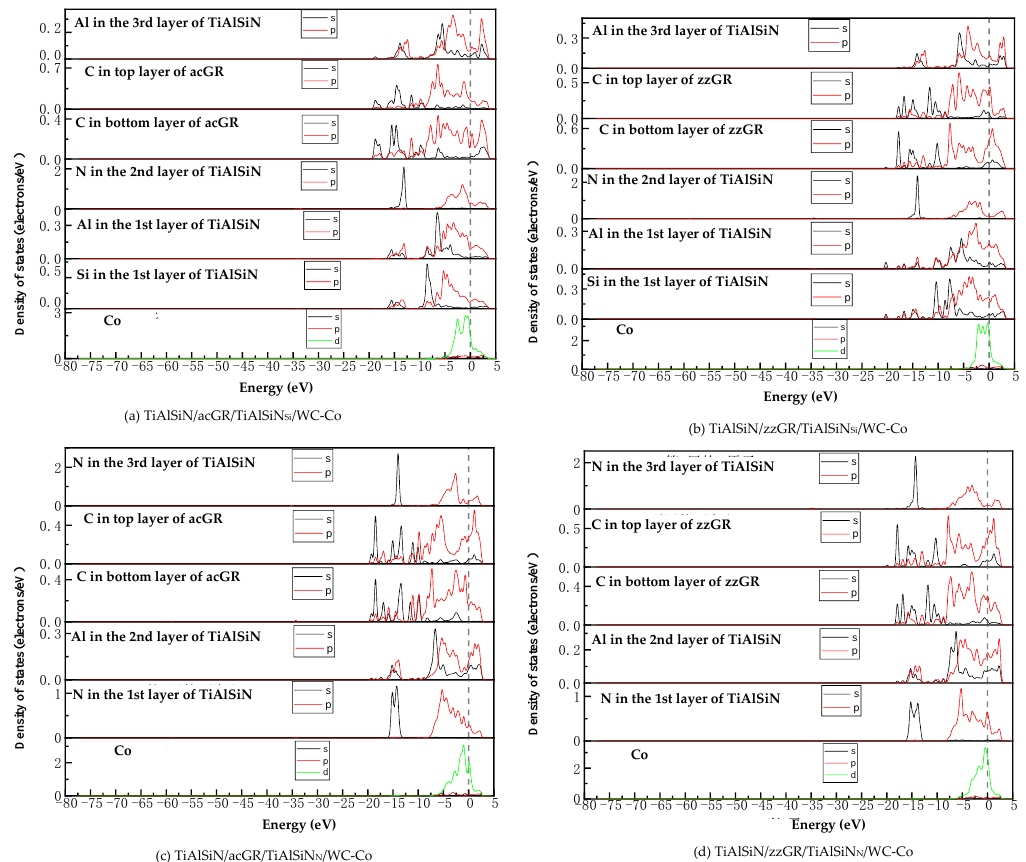
Figure 19. PDOS of the interface models with the coating doped with an intrinsic graphene boundary.